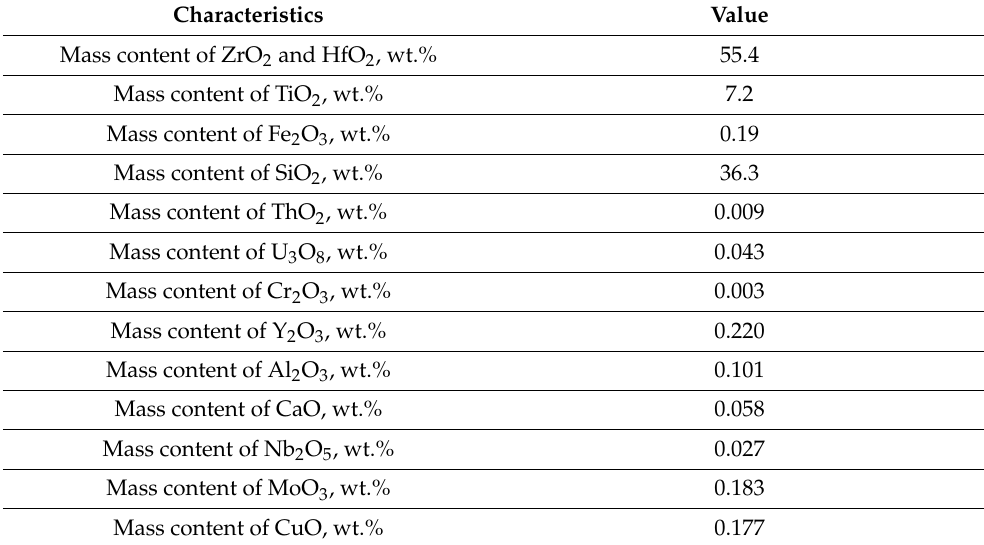
Table 10. Chemical composition. Characteristics Value Mass content of ZrO 2 and HfO 2 , wt.%